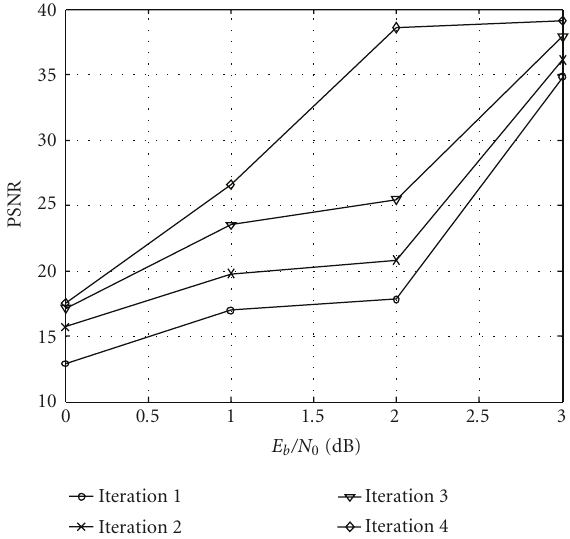
Figure 13: Decoded image quality (in PSNR) of proposed asym- metric turbo code with inetrleaver over AWGN channel.